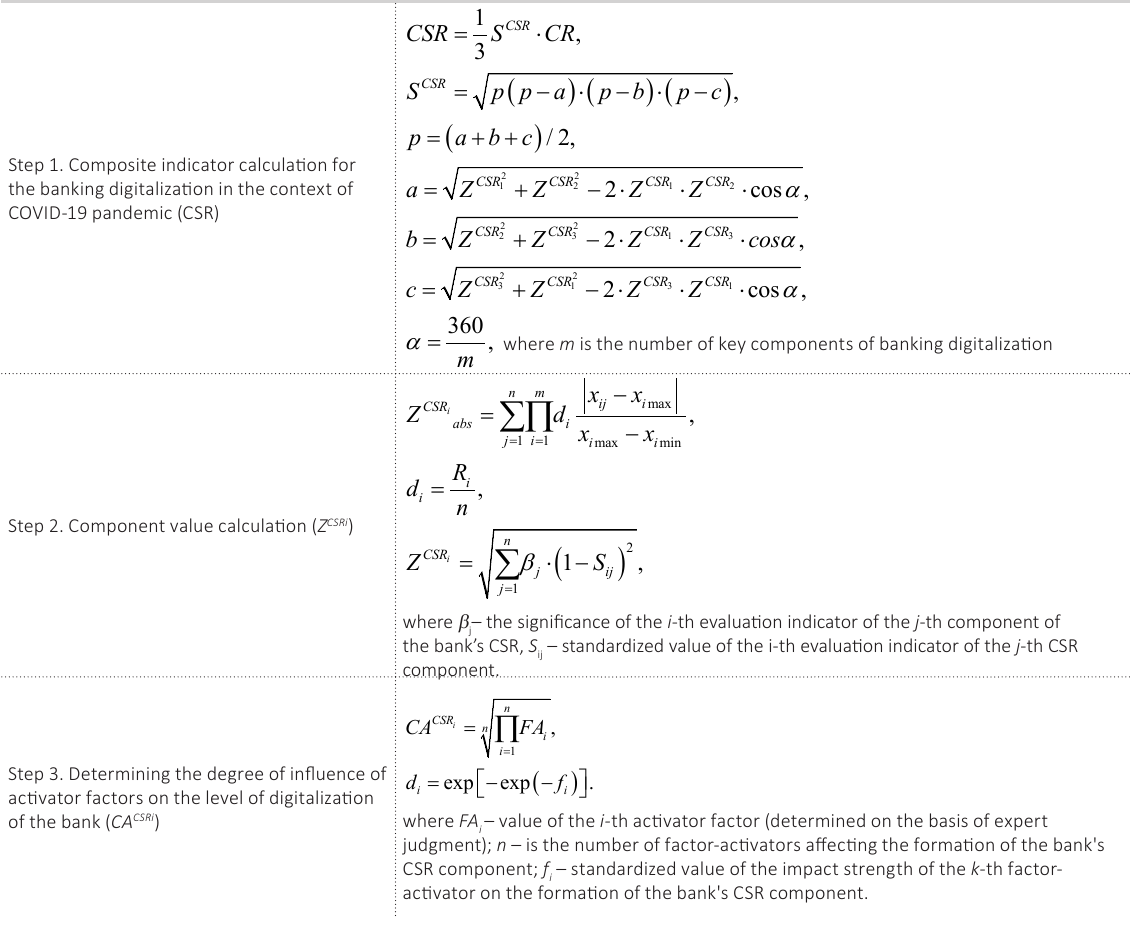
Figure 1. Development level calculation of banking digitalization in the context of the COVID-19